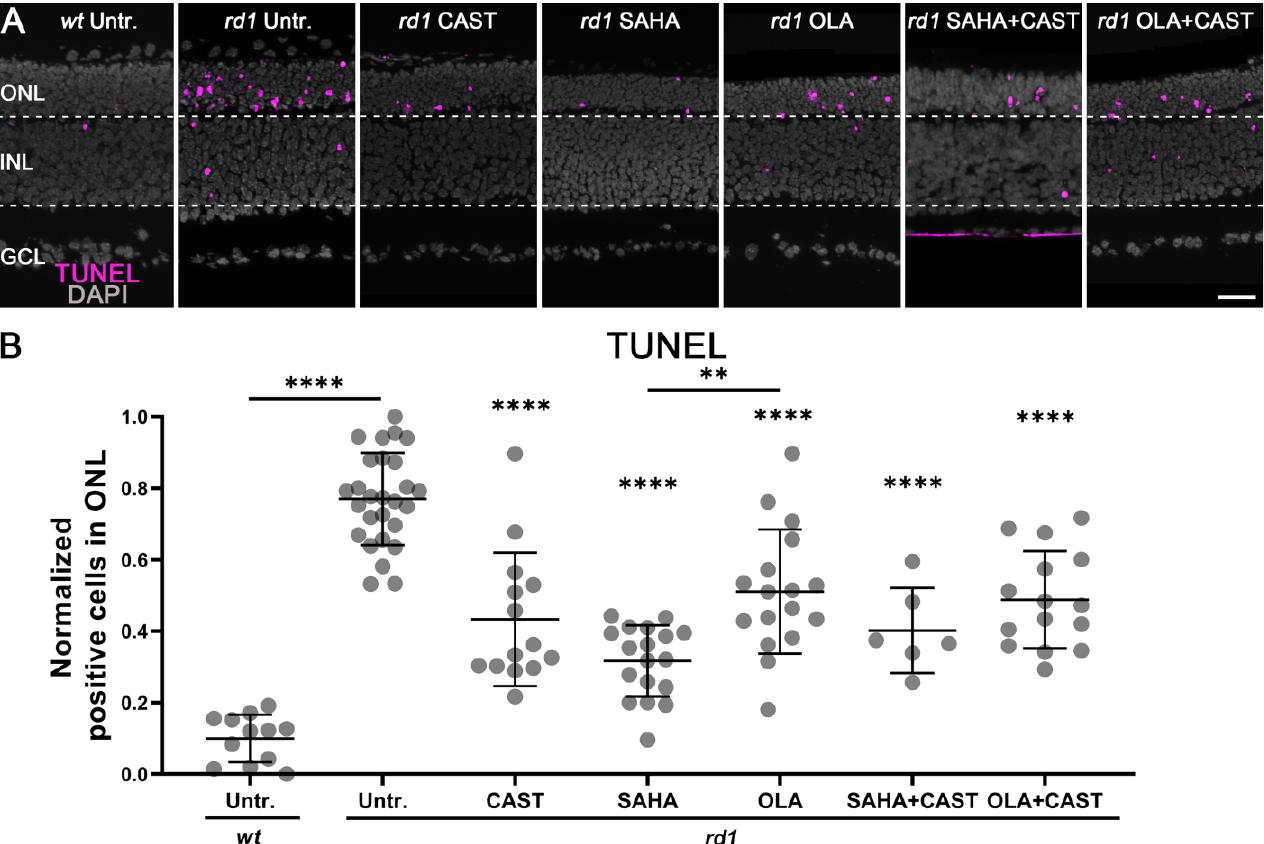
Figure 1. Effects of mono- and combination therapies on photoreceptor cell death. Retinal explant cultures derived from either wild-type ( wt ) or rd1 animals were treated until post-natal day 11 with specific inhibitors targeting calpain (CAST), HDAC (SAHA), or PARP (OLA), or were treated with combinations of these inhibitors. ( A ) Retinal cross-sections obtained from treated or untreated (Untr.) specimens were stained with the TUNEL assay (magenta) to detect dying cells. DAPI (grey) was used as nuclear counterstain. ( B ) Normalized quantification ( rd1 max value = 1, wt min value = 0) of cell death in the outer nuclear layer (ONL) in the various treatment groups. Note the strong increase in ONL cell death in rd1 retina compared to wt and the decreased cell death rates afforded by the various treatments. Combined treatment with either SAHA + CAST or OLA + CAST did not produce additional rescue effects compared to single drug treatment. Images shown represent at least six different specimens for each genotype. Untr. wt : 12 explants from 12 different mice; untr. rd1 : 27/27; CAST rd1 : 14/14; SAHA rd1 : 18/18; OLA rd1 : 17/17; SAHA + CAST rd1 : 6/6; OLA + CAST rd1 : 15/15; error bars represent SD; INL = inner nuclear layer; GCL = ganglion cell layer. Scale bar = 50 μm; significance levels: **, p < 0.01; ****, p < 0.0001.